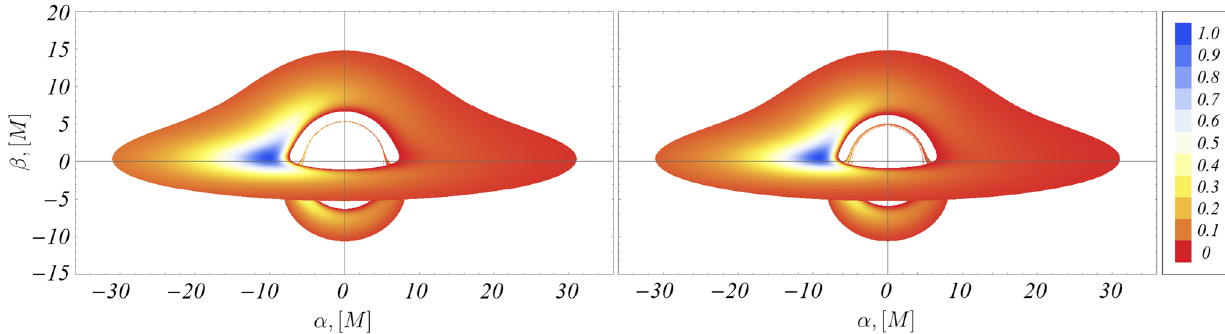
Fig. 2 Apparent radiation flux for the Gauss–Bonnet black hole with ˆ γ = 1 (left), and for the Schwarzschild black hole (right). The observer is located at r obs = 5000 M , and at the inclination angle i = 80 ◦